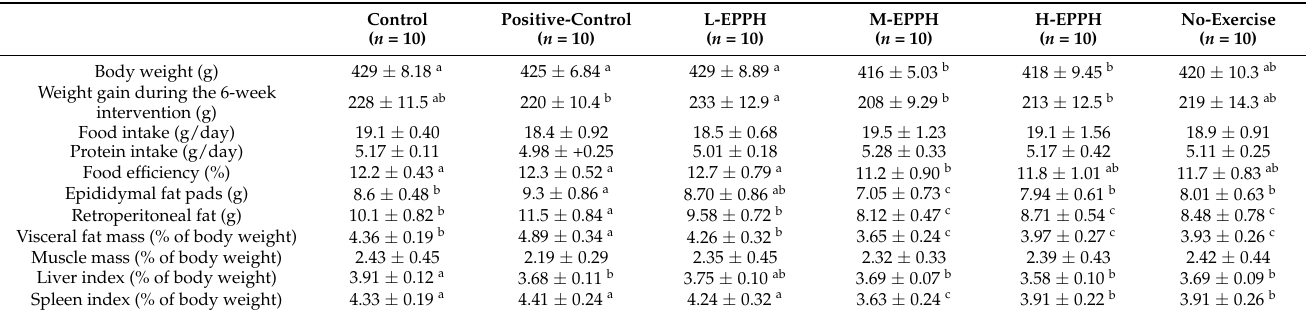
Table 2. Body weight, food intake, and visceral fat mass after the 6-week intervention.